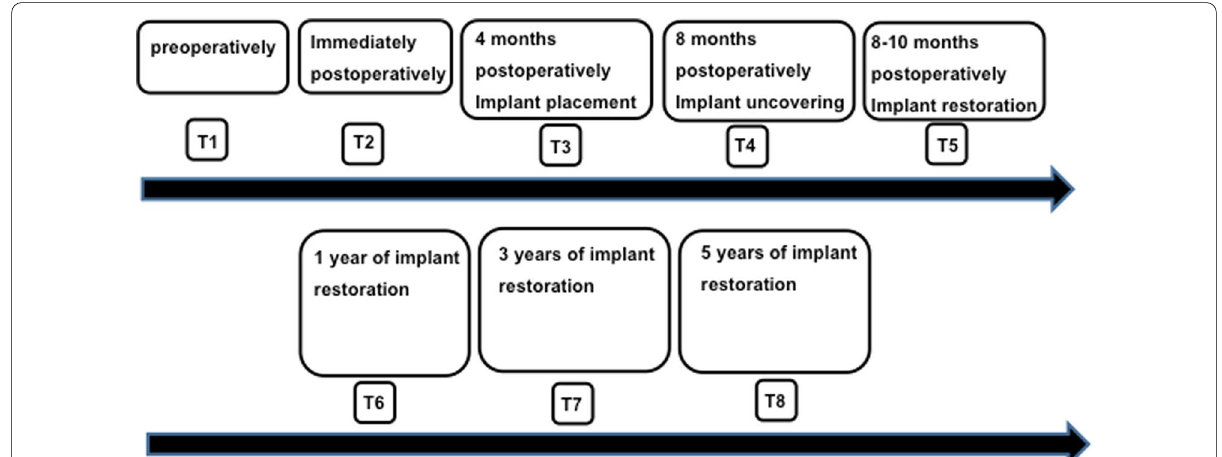
Fig. 1 Flowchart of the study design showing the eight different time points of measurements of alveolar bone crest